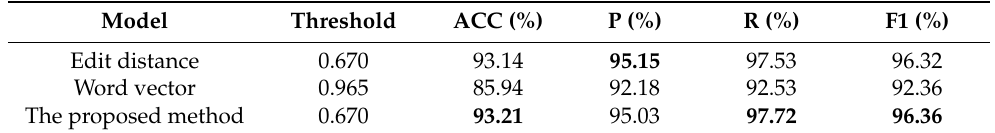
Table 9. The performance of the models.